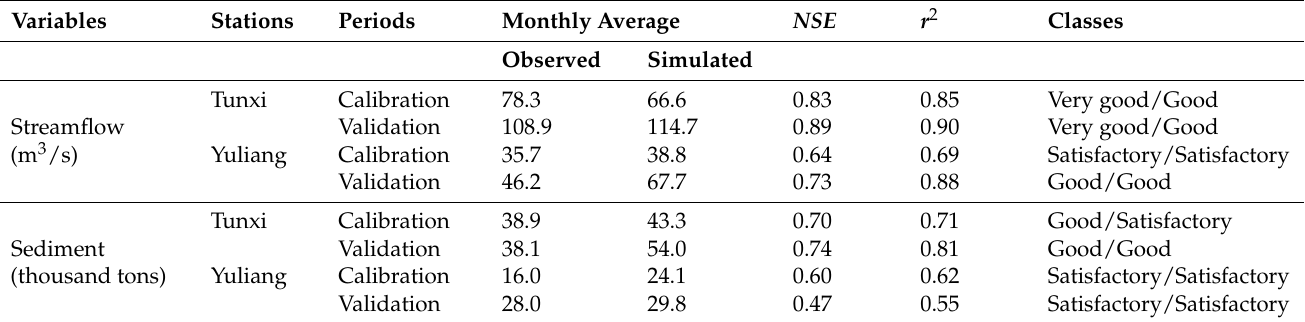
Figure 5. A comparison between the observed and modeled monthly streamflow in XRB during the calibration (2001–2010) and validation (2011–2014) periods. ( a ) The comparison result for Tunxi Station; ( b ) the comparison result for Yuliang Station. Table 3. The SWAT performance during the calibration and validation